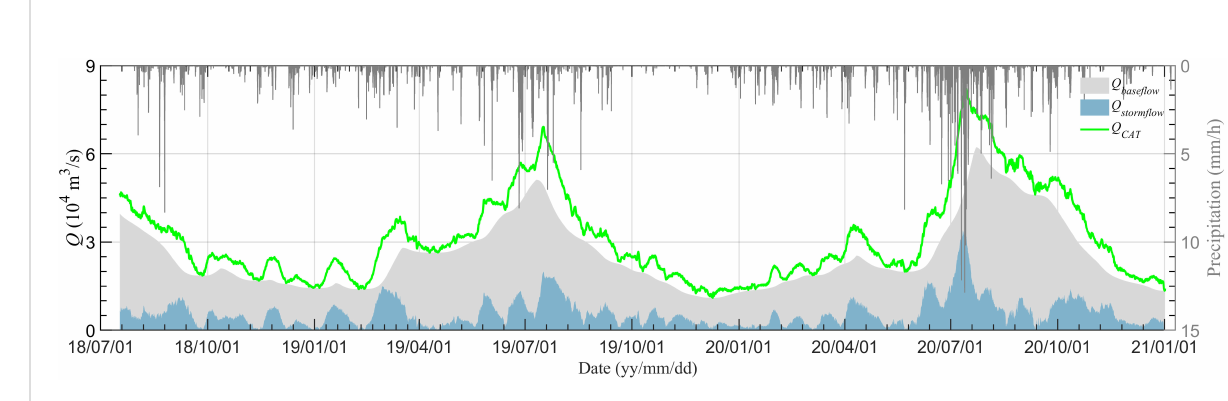
FIGURE 7 Time series of base fl ow and storm fl ow obtained from Q CAT during the observation period (July 2018 to January